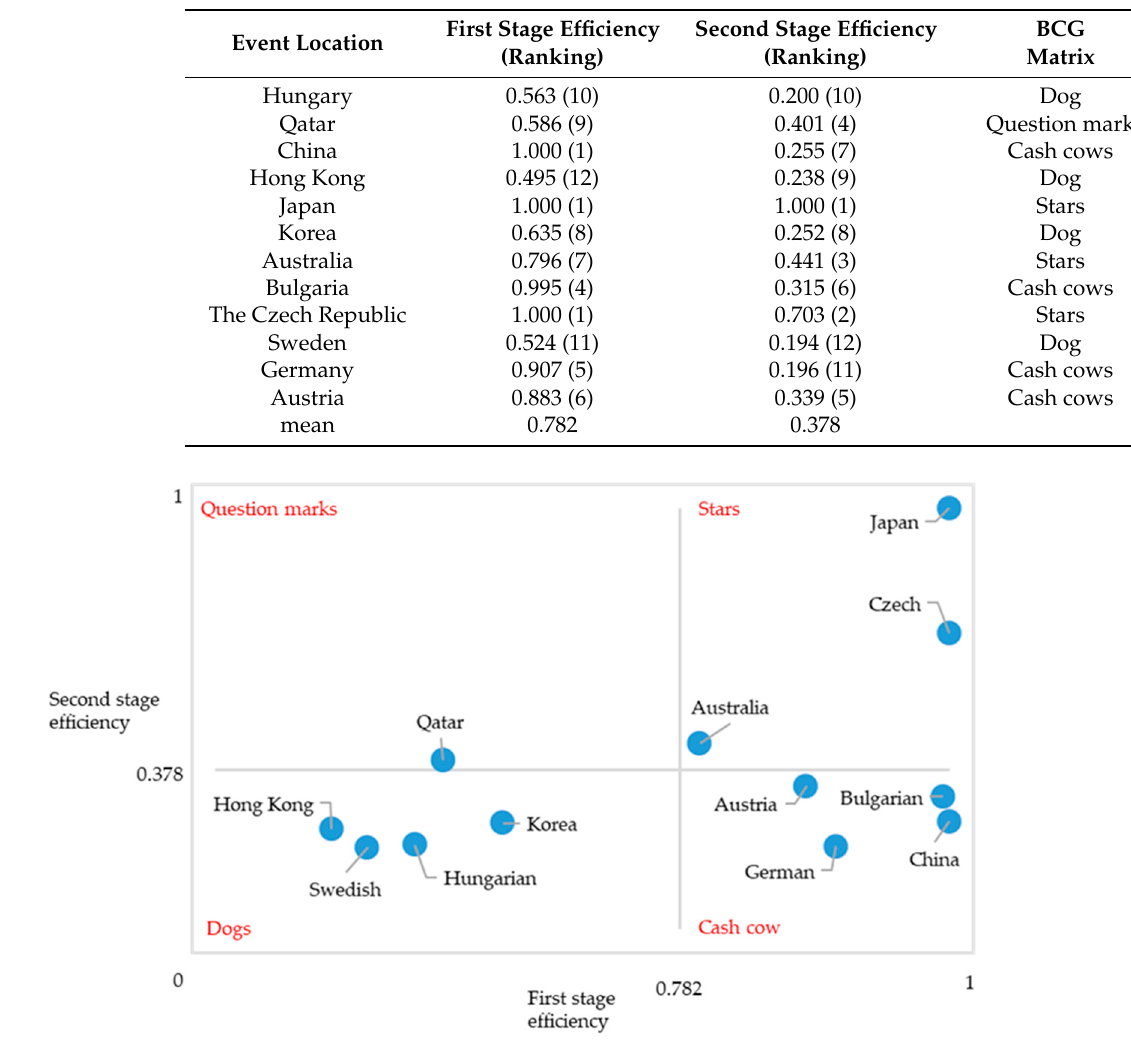
Figure 3. Game BCG matrix for the 2021 ITTF World Tour.